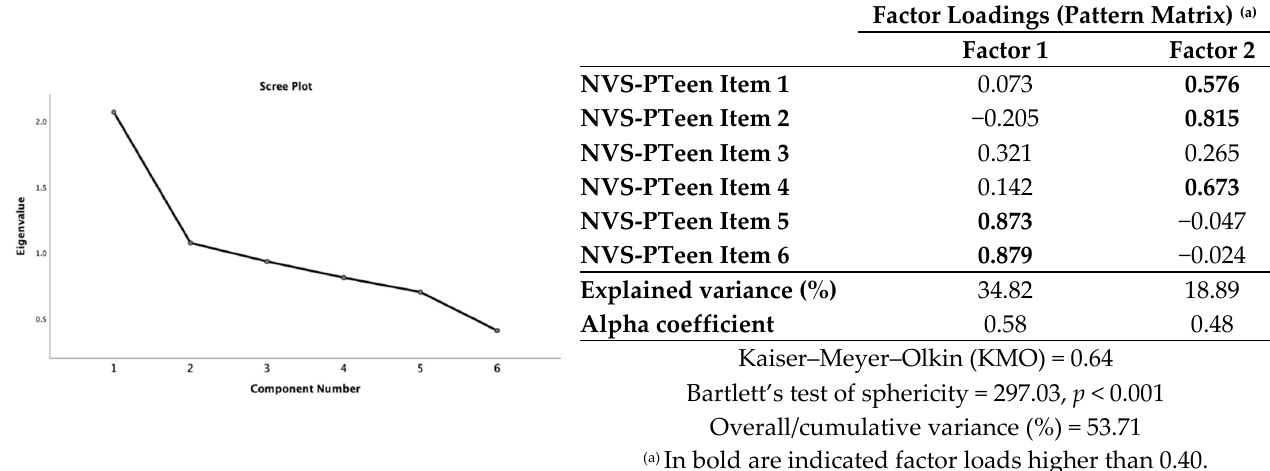
Figure 2. NVS-PTeen items: characteristic and information curves ( N = 386).